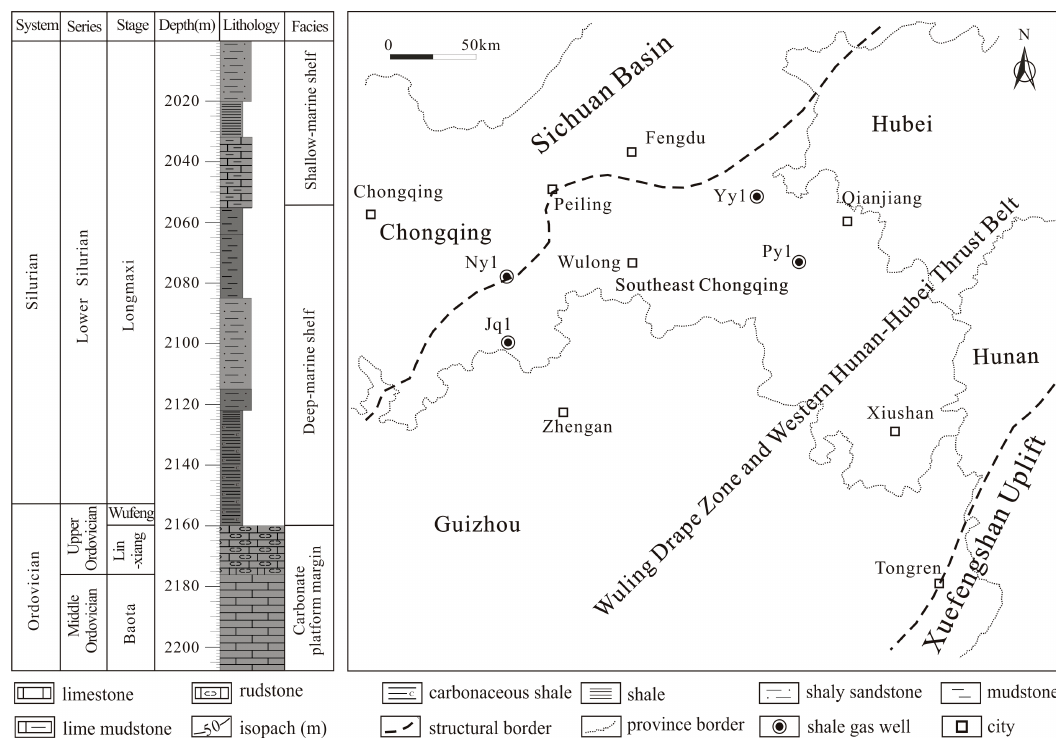
Figure 1. The stratigraphic column of the Py1 well and location of Southeast Chongqing, China.